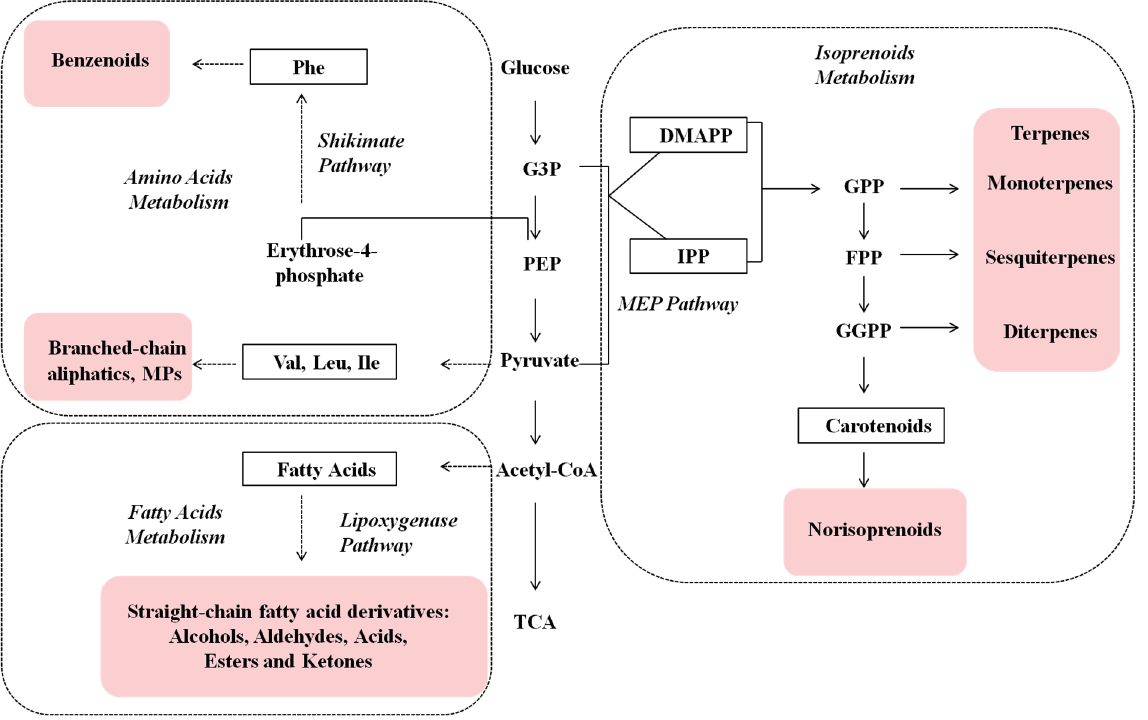
Figure 1. Biosynthetic pathways of three classes of volatile compounds in grapes. Metabolism and pathway names are italicized, whereas volatiles are in pink